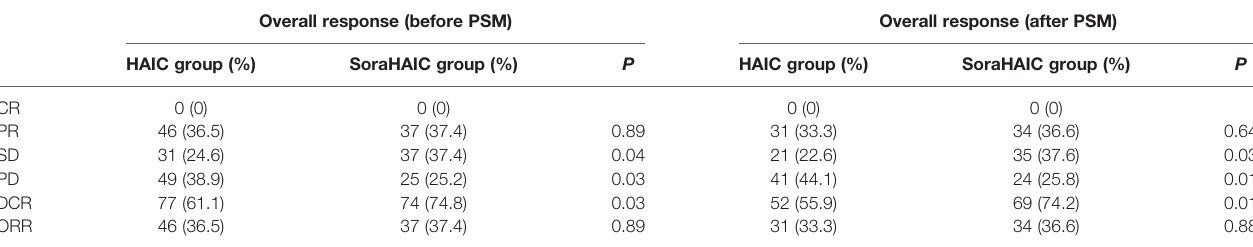
TABLE 3 | Summary of best response based on the RECIST